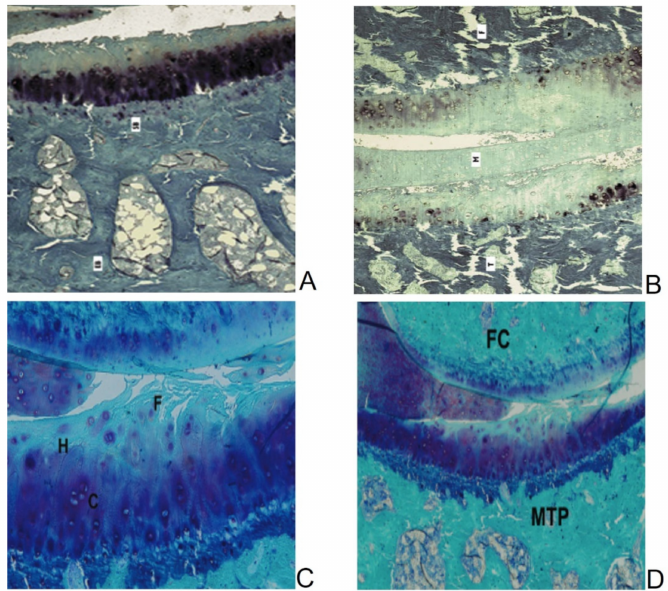
Figure 2. ( A ) Medial tibial plateau and ( B ) medial articular compartment of DH guinea pigs at 12 months of age. Surface irregularities and loss of staining in the superficial and medial cartilage surfaces are visible. ( C ) Medial tibial plateau and ( D ) medial articular compartment of DH guinea pigs at 21 months of age. High fibrillation, reduced staining, and cartilage thickness are observed. SB: subchondral bone, EB: epiphyseal bone, T: medial tibial plateau, F: medial femoral condyle, M: meniscus, H: Hypocellularity zone; C: clusters; FC: femoral condyle, MTP: medial tibial plateau. Toluidine blue/Fast Green staining. ( A , C ) 50 × of magnification; ( B , D ) 8 × of